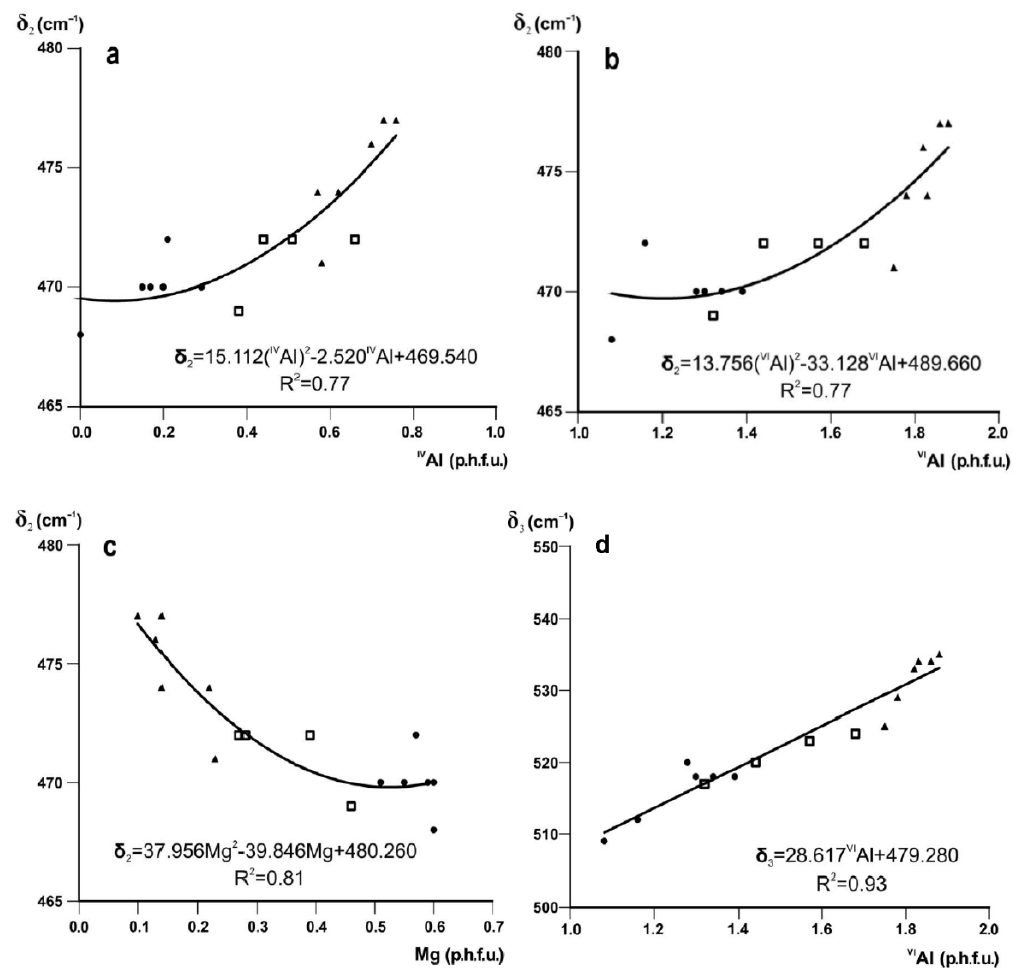
Figure 3. Band positions (cm − 1 ) of δ 2 and δ 3 in Fe-poor K-dioctahedral 1 M micas plotted vs. octahedral cation contents: ( a ) δ 2 vs. IV Al; ( b ) δ 2 vs. VI Al; ( c ) δ 2 vs. Mg; ( d ) δ 3 vs. VI Al (cations p.h.f.u. ). Symbols as in Figure 2.